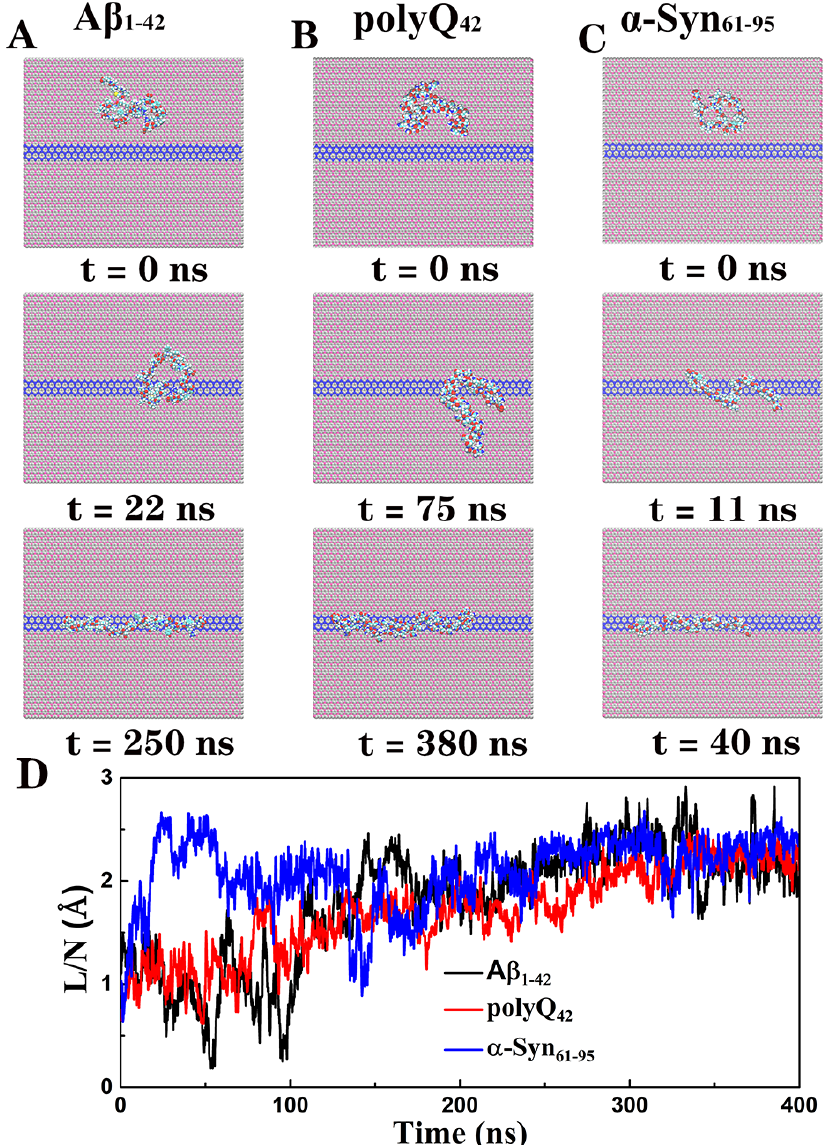
Figure 2. Representative snapshots of stretching processes of ( A ) A β 1–42 , ( B ) polyQ 42 , and ( C ) α -Syn 61–95 on BC 3 /C 3 N/BC 3 . ( D ) End-to-end distances for A β (black line), polyQ (red line), α -Syn (blue line) during the simulations.